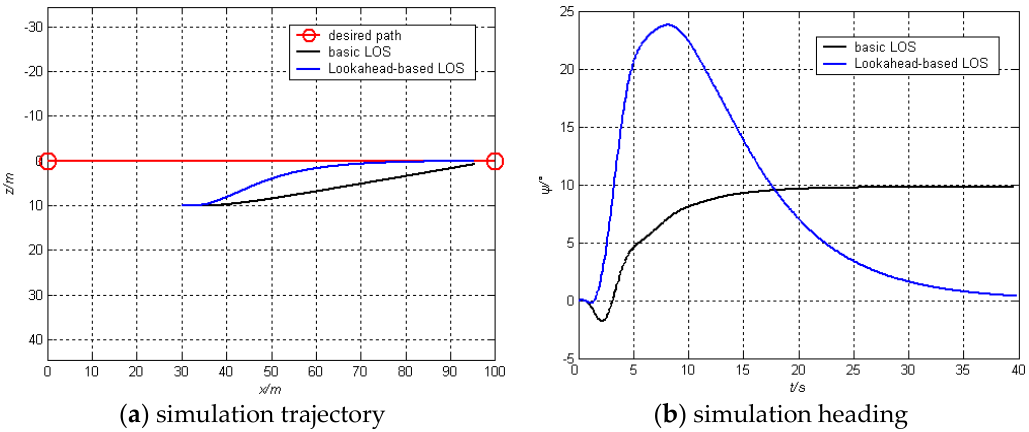
Figure 15. Path following performance when deviation occurs.